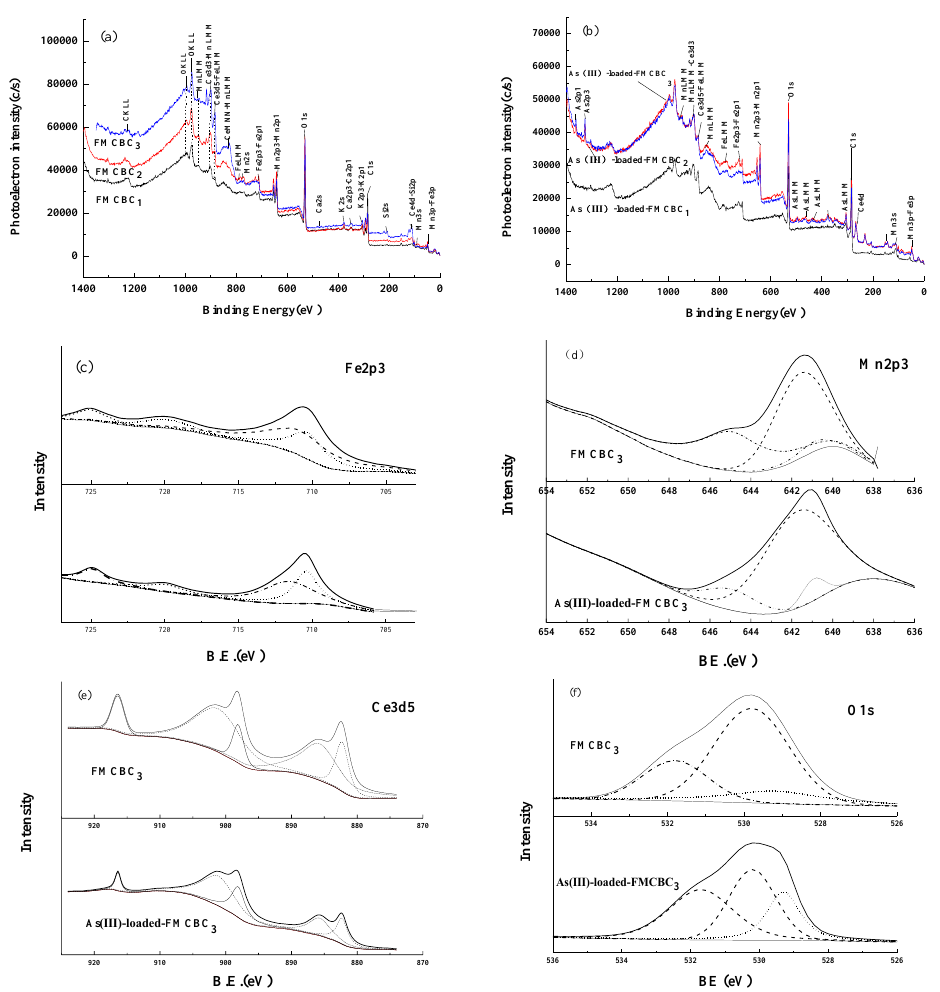
Figure 3. XPS analysis of FMBC with pre- and post As(III) adsorption The X-ray (( a ) the XPS spectra of FMCBCs; ( b ) the XPS spectra of As(III)-loaded-FMCBCs; ( c ) Fe2p; ( d ) Mn2p3/2; ( e ) Ce3d5; ( f ) O1s the spectra of FMCBC 3 ).